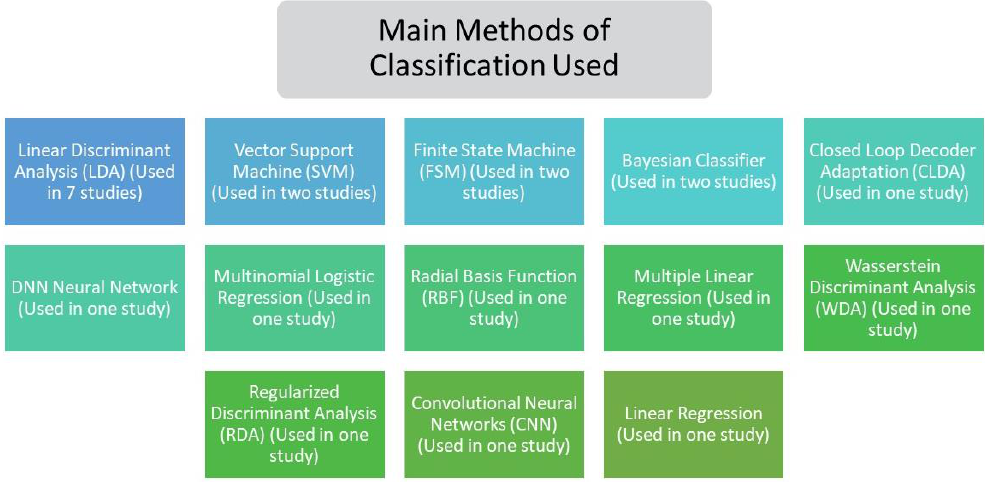
Figure 6. Methods used in the classification and modeling of the control system of the included proposals.